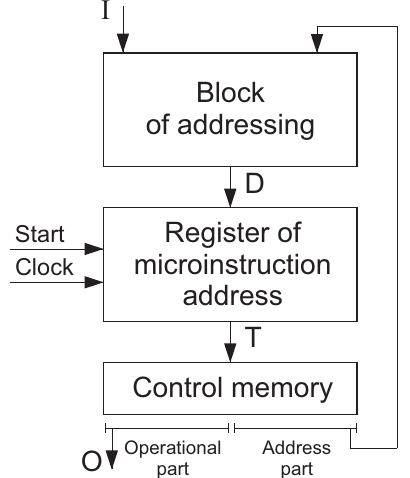
Figure 4. Two-level microprogram control